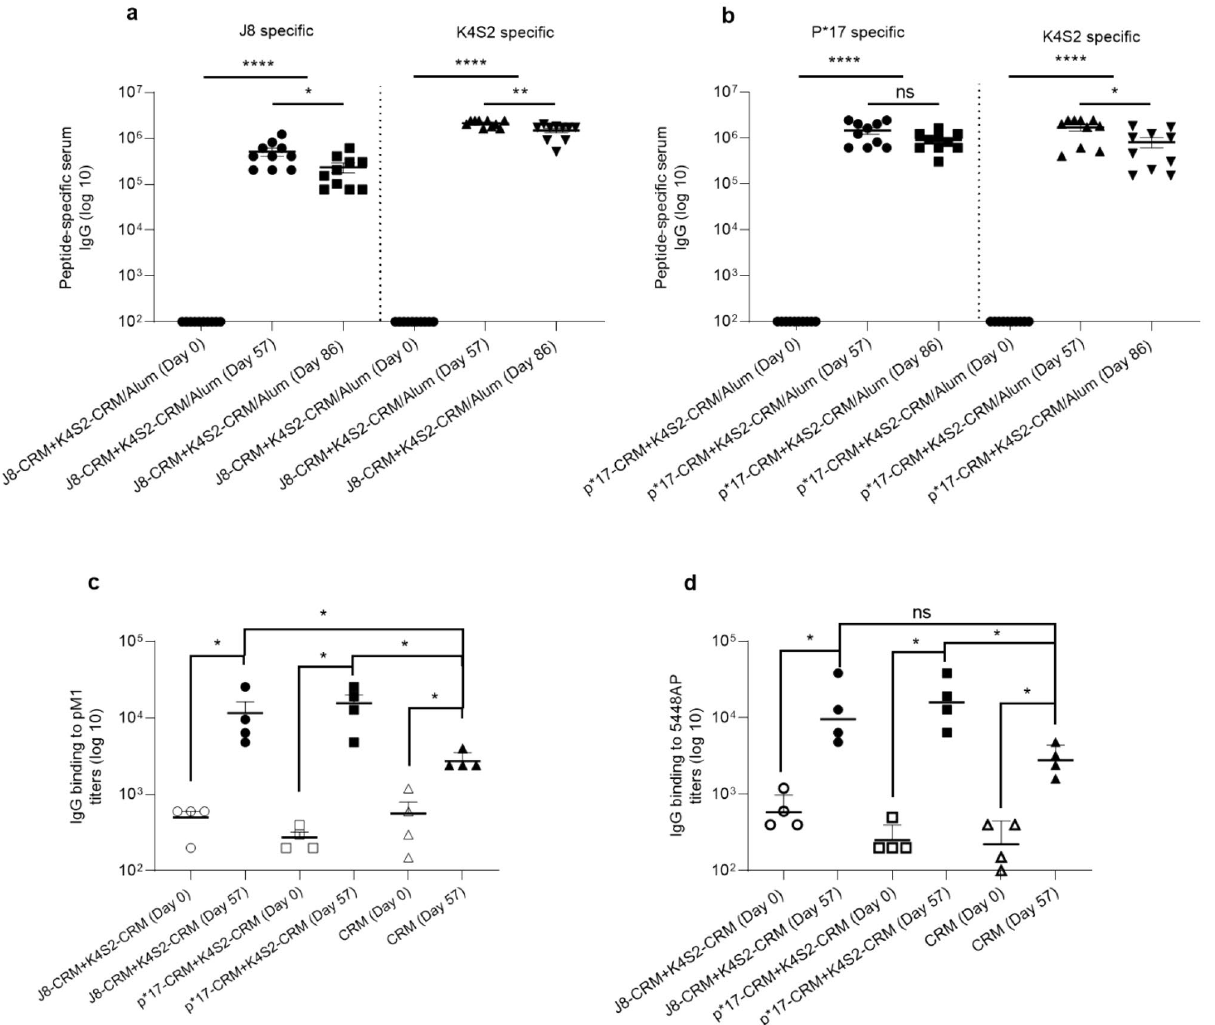
Figure 3. Vaccine immunogenicity and functionality of vaccine-induced antibodies. ( a , b) Vaccine peptide specific serum IgG titers induced in Sprague–Dawley rats after vaccination with J8-CRM + K4S2-CRM/Alum or p*17-CRM + K4S2-CRM/Alum. Sprague–Dawley rats were immunized intramuscularly with 0.1 mg/dose of J8-CRM + K4S2-CRM/Alum or p*17-CRM + K4S2-CRM/Alum on days 0, 21 and 42. Rats were euthanized at day 57 and day 86. J8, p*17 and K4S2 specific serum IgG titers (Geomean) are shown for individual rats vaccinated with J8-CRM + K4S2-CRM/Alum ( a ) or p*17-CRM + K4S2-CRM/Alum ( b ) euthanized at day 57 (n = 10; 5 male, 5 female) or 86 (n = 10; 5 male, 5 female). Pre-vaccination (day 0) serum IgG titers of the same rats assessed at day-57 or -87 are also shown. Samples were considered positive when the mean value of the absorbance, of the highest dilution (1:100), was > 3SD above the mean OD of the negative control. ( c , d ) Strep A surface binding of vaccine induced antibodies. Sera collected from rats vaccinated with J8-CRM + K4S2- CRM/Alum, p*17-CRM + K4S2-CRM/Alum or CRM/Alum in the toxicology study was assessed for direct IgG binding to heat killed pM1 ( c ) and 5448AP ( d ). Mean individual titers of sera collected from days-0 (n = 4) and -57 (n = 4) and assayed by ELISA are shown. Statistical analysis and graphs generated using a Mann–Whitney test to compare all groups, were performed using GraphPad Prism (8.1.2) * p < 0.05, ** p < 0.01, *** p < 0.001, **** p < injection sites and inguinal lymph nodes in males and/or females, and adrenocortical hypertrophy in males. All observations were considered non-adverse. At day-57 sacrifice, the overall incidence of granulomatous inflammation observed at the right and left injec- tion sites was comparable between the control group and the vaccine groups (Supplementary Table S2). There was a slight increase in the severity of the granulomatous inflammation in both the left and right injection sites of male rats and the right injection site of female rats that received J8-CRM + K4S2-CRM/Alum. Likewise, there was a small increase in severity of the granulomatous inflammation in the left and right injection sites of female rats and the left injection site of male rats that received p*17-CRM + K4S2-CRM/Alum. At day 86, a slight increase in severity of granulomatous inflammation persisted in the right injection site of one of five female rats that received p*17-CRM + K4S2-CRM/Alum. No evidence of persisting granulomatous inflammation was observed